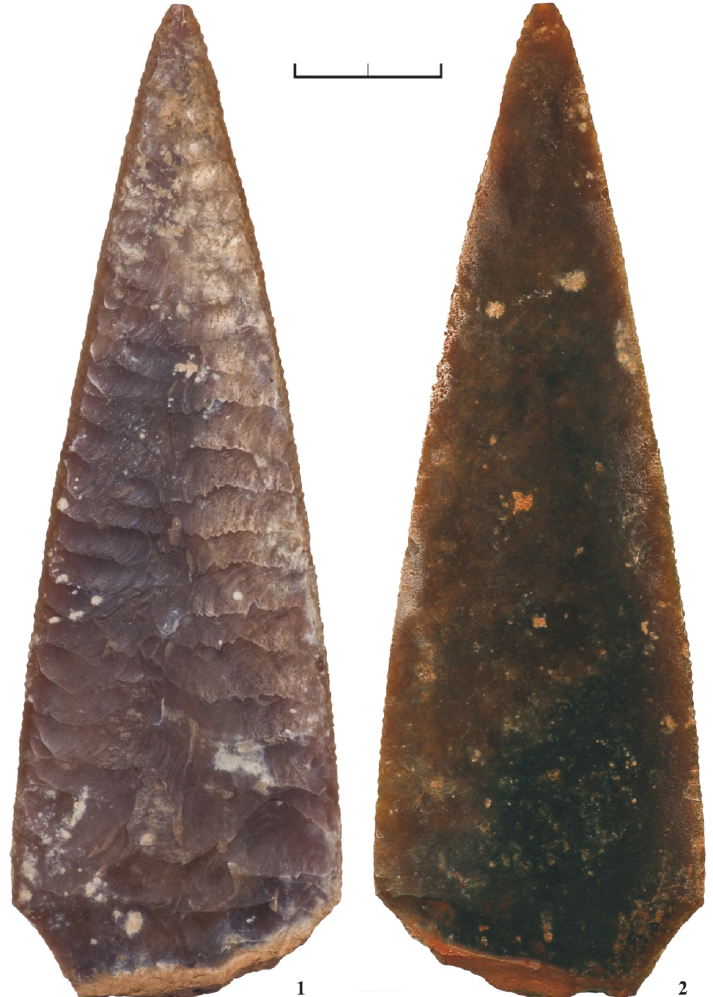
Figure 8. Forcalquier chert dagger, Chataigners type, recovered in Cova de l’Avi. (Photo by J. Vaquer.) Scale bars = 2 cm (in 1 cm